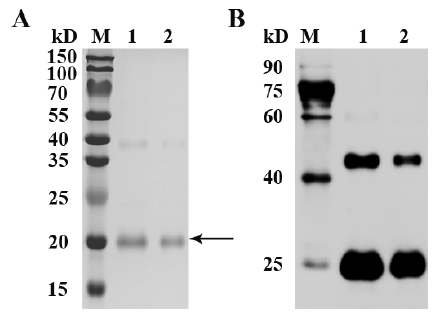
Figure 2. SDS-PAGE ( A ) and Western blot ( B ) analysis of recombinant goose FST protein. SDS-PAGE gel was stained with Coomassie blue. Arrow indicates the target protein. After incubation with an anti-His tag primary antibody followed by an HRP-conjugated secondary antibody, immuno-reactive bands were visualized with ECL reagent. M, protein standards; 1 and 2, purified proteins.